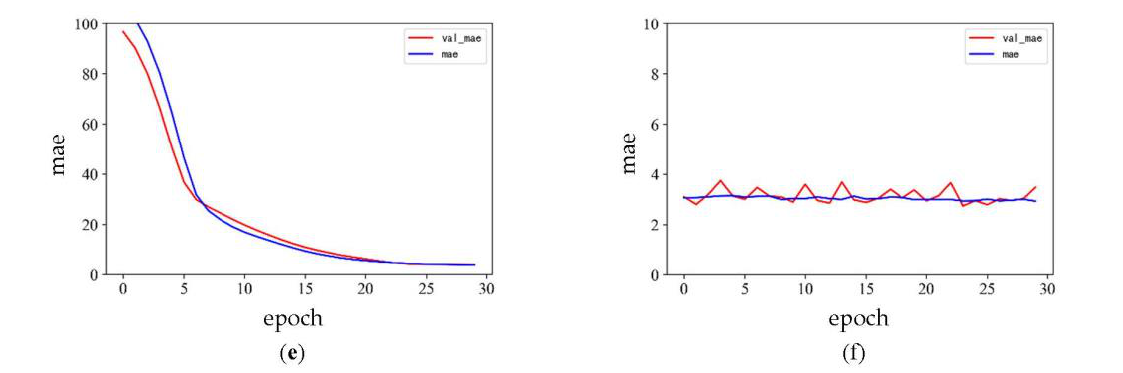
Figure 11. Comparison of prediction errors between the deep network and the shallow network: ( a ) shallow network diagram; ( b ) deep network diagram; ( c ) trainable parameters of the shallow network; ( d ) trainable parameters of deep network; ( e ) training error (blue curve) and test error (red curve) of the shallow network; ( f ) training error (blue curve) and test error (red curve) of deep network.